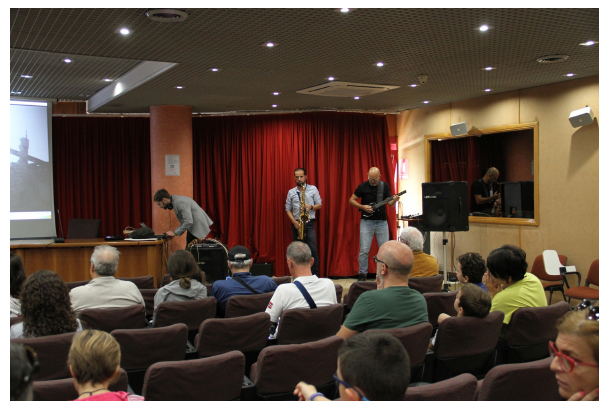
Figure 7. INGV open day in